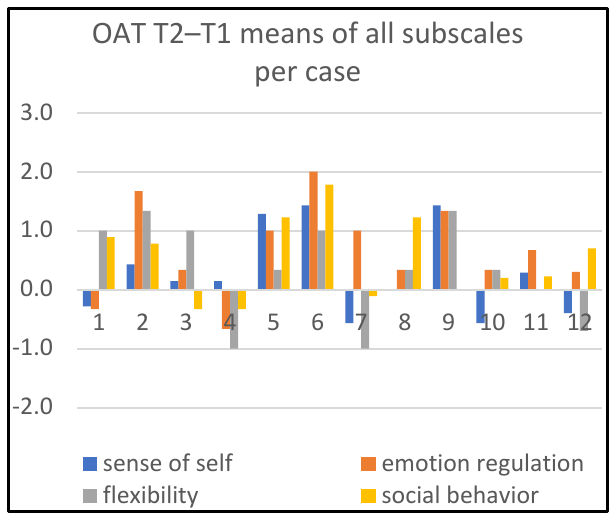
Figure 1. Means of all subscales per case, T2–T1.